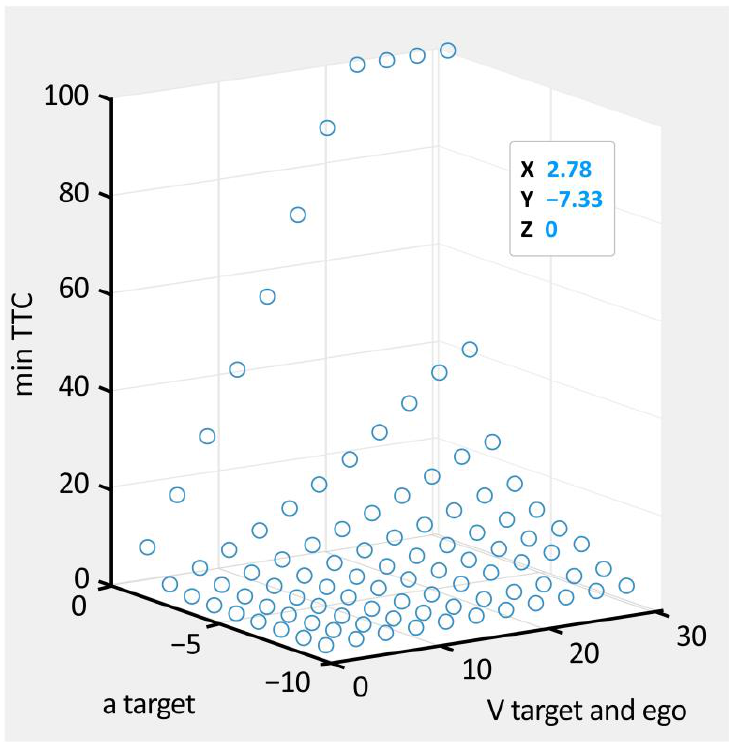
Figure 4. Concrete scenario modeling results.